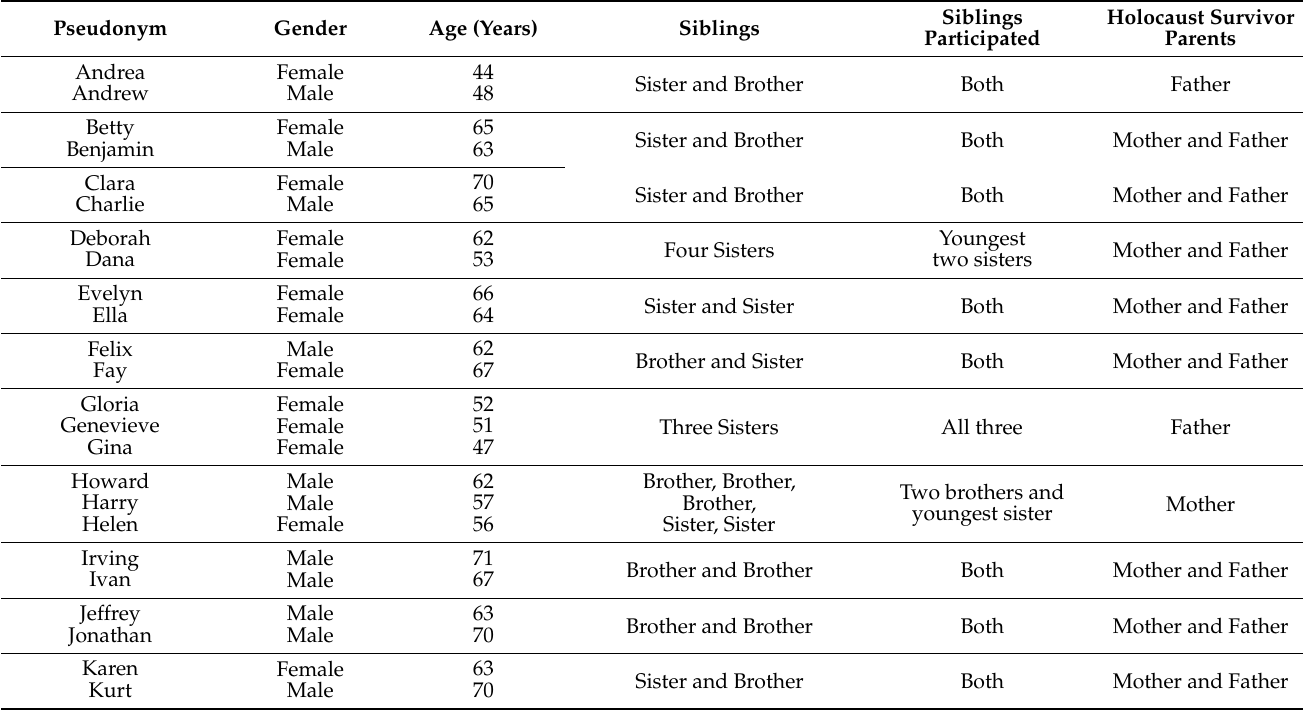
Table 1. Participant Family